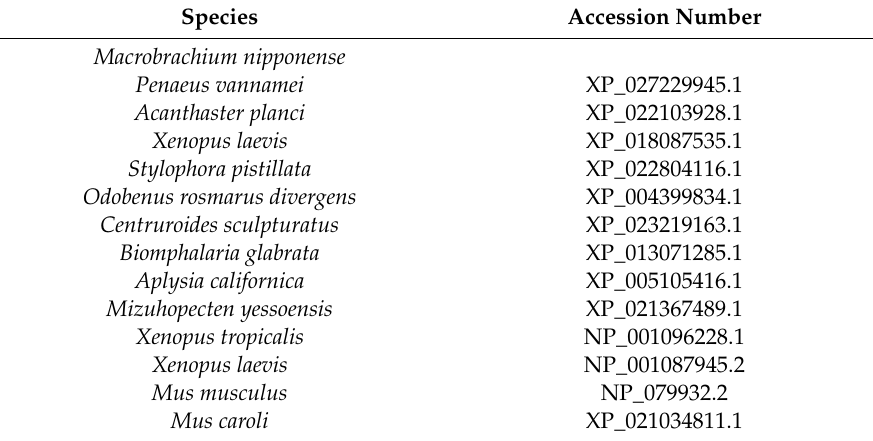
Table 1. Amino acid sequence used for phylogenetic analysis of GEM .